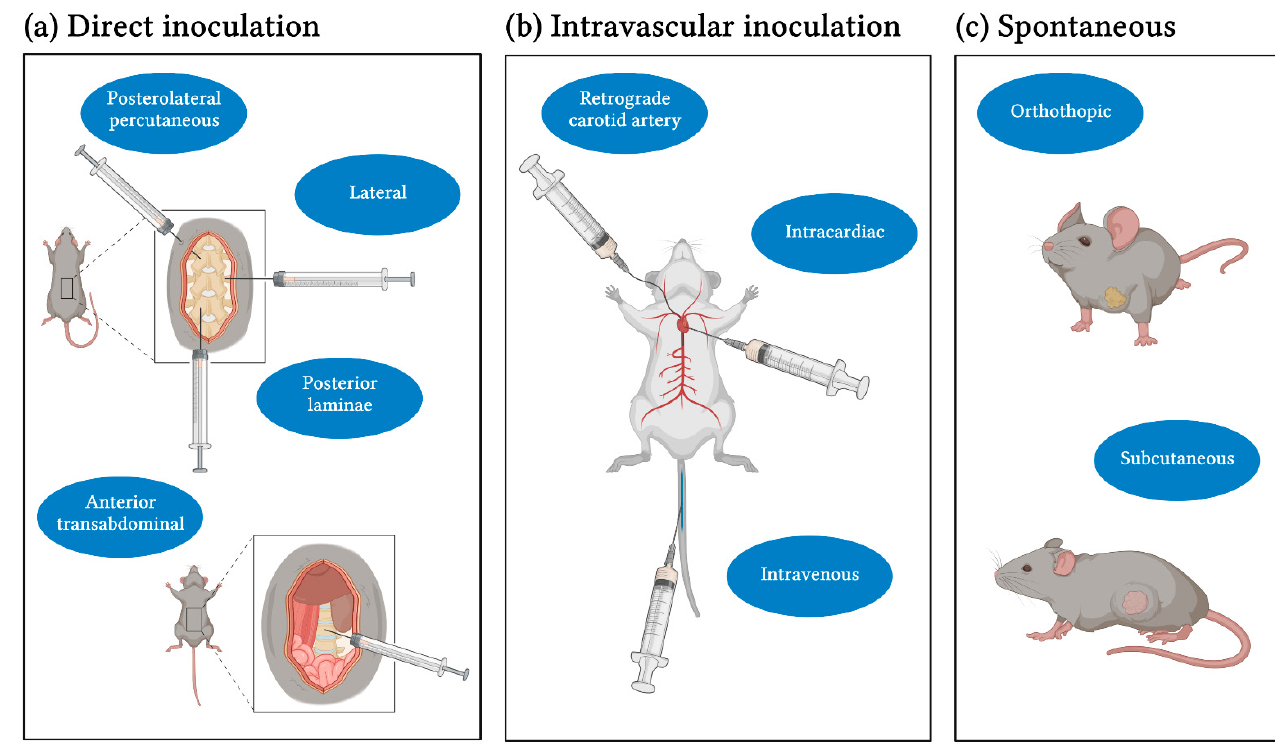
Figure 1. Overview of inoculation methods in experimental research of spinal metastasis. ( a ) Direct implantation methods lead to spinal metastasis with high reproducibility, but only the last steps of the metastatic cascade are depicted. Important advantages provided by direct inoculation methods are the rapid local growth which is limited to spinal structures. Therefore, it is well suited for the systematic investigation of clinical characteristics. ( b ) Using intravascular inoculation methods, earlier key steps including dissemination, circulation and extravasation mechanisms of tumor cells can be investigated. The preselection of the capillary bed through which the tumor cells pass first is to be mentioned as an advantage and disadvantage. This is realized by the choice of vessel (intravenously: lung → brain/body; intracardially: brain/body → lung; distal aortic arch: spine/body → lung → brain). ( c ) Spontaneous models are the only ones which are capable to recapitulate the whole metastatic process including early steps of the metastatic process. Therefore, they are suitable to investigate every step of the multistep cascade and current research questions as the formation of the premetastatic niche, organotropism to spine, tumor cell dormancy and the influence and regulating function of the immune system can be addressed. As they include primary tumor growth, they are the most realistic one and the influence of surgical resection on metastatic spread can be investigated. A disadvantage of these models, however, is the challenge to create reproducible metastases at a high frequency. Additionally, the investigation period can be limited due to metastasis to other sites which might occur prior to spinal metastasis (e.g., lung). Figure 1 was created with BioRender.com.